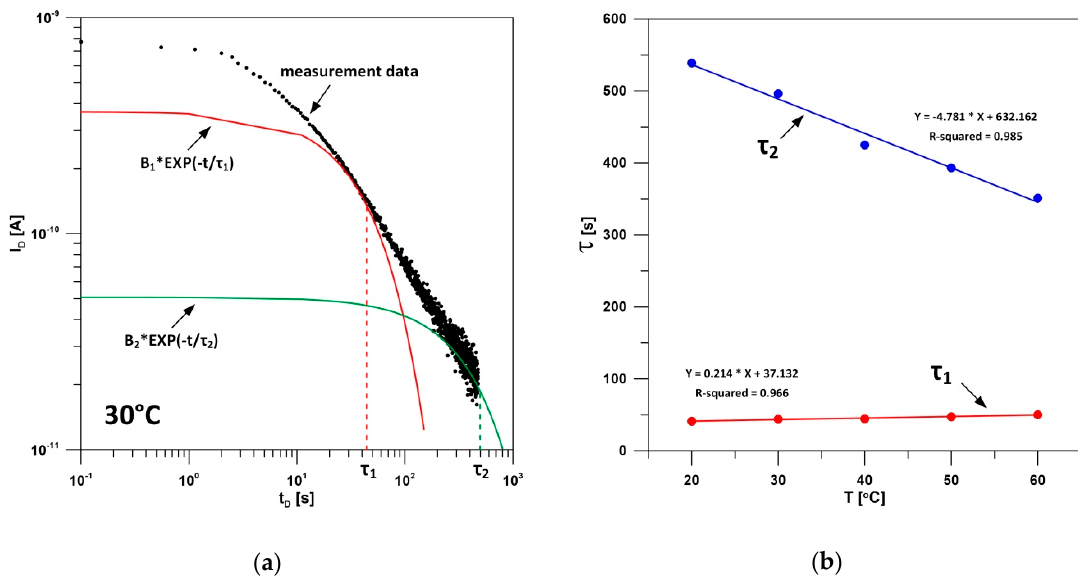
Figure 7. Analysis of time characteristics of the depolarization current by means of Debye regression function for a selected cellulose–aramid insulation sample (aged at 150 °C with the smallest moisture), mineral oil-impregnated: ( a ) depolarization current in the measurement temperature 30 °C; ( b ) temperature dependence of the dominant time constants for two relaxation processes.